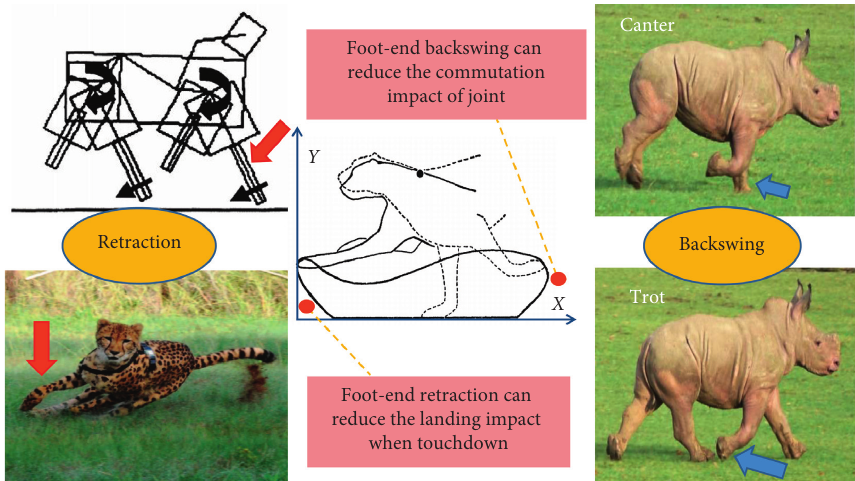
Figure 2: The backswing and retraction of feet during animal movements